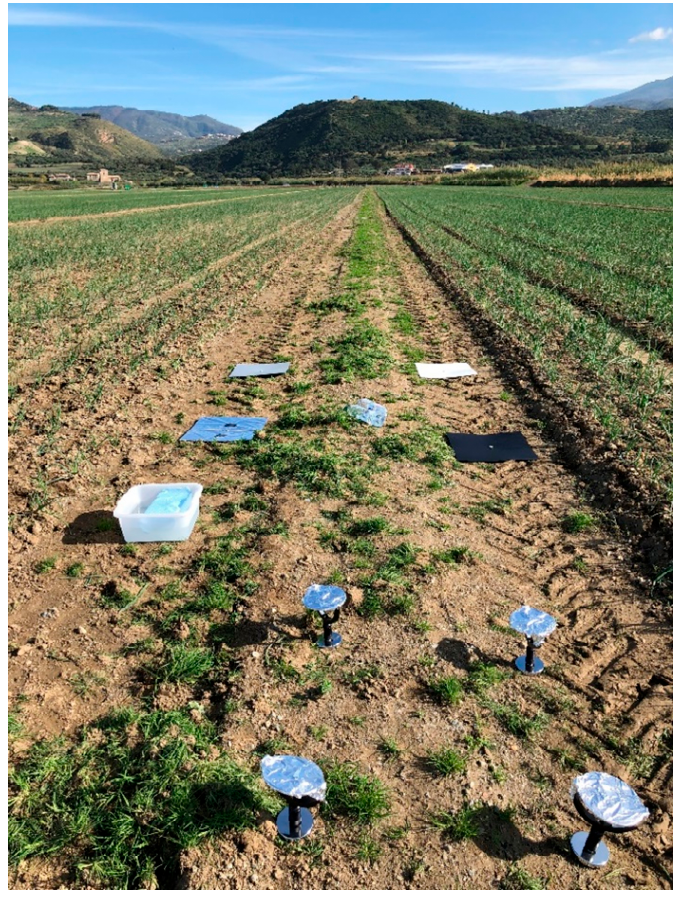
Figure 4. The temperature reference targets used during thermal unmanned aerial vehicle (UAV) surveys in an onion crop field in Calabria (Italy) (photo taken by the authors).